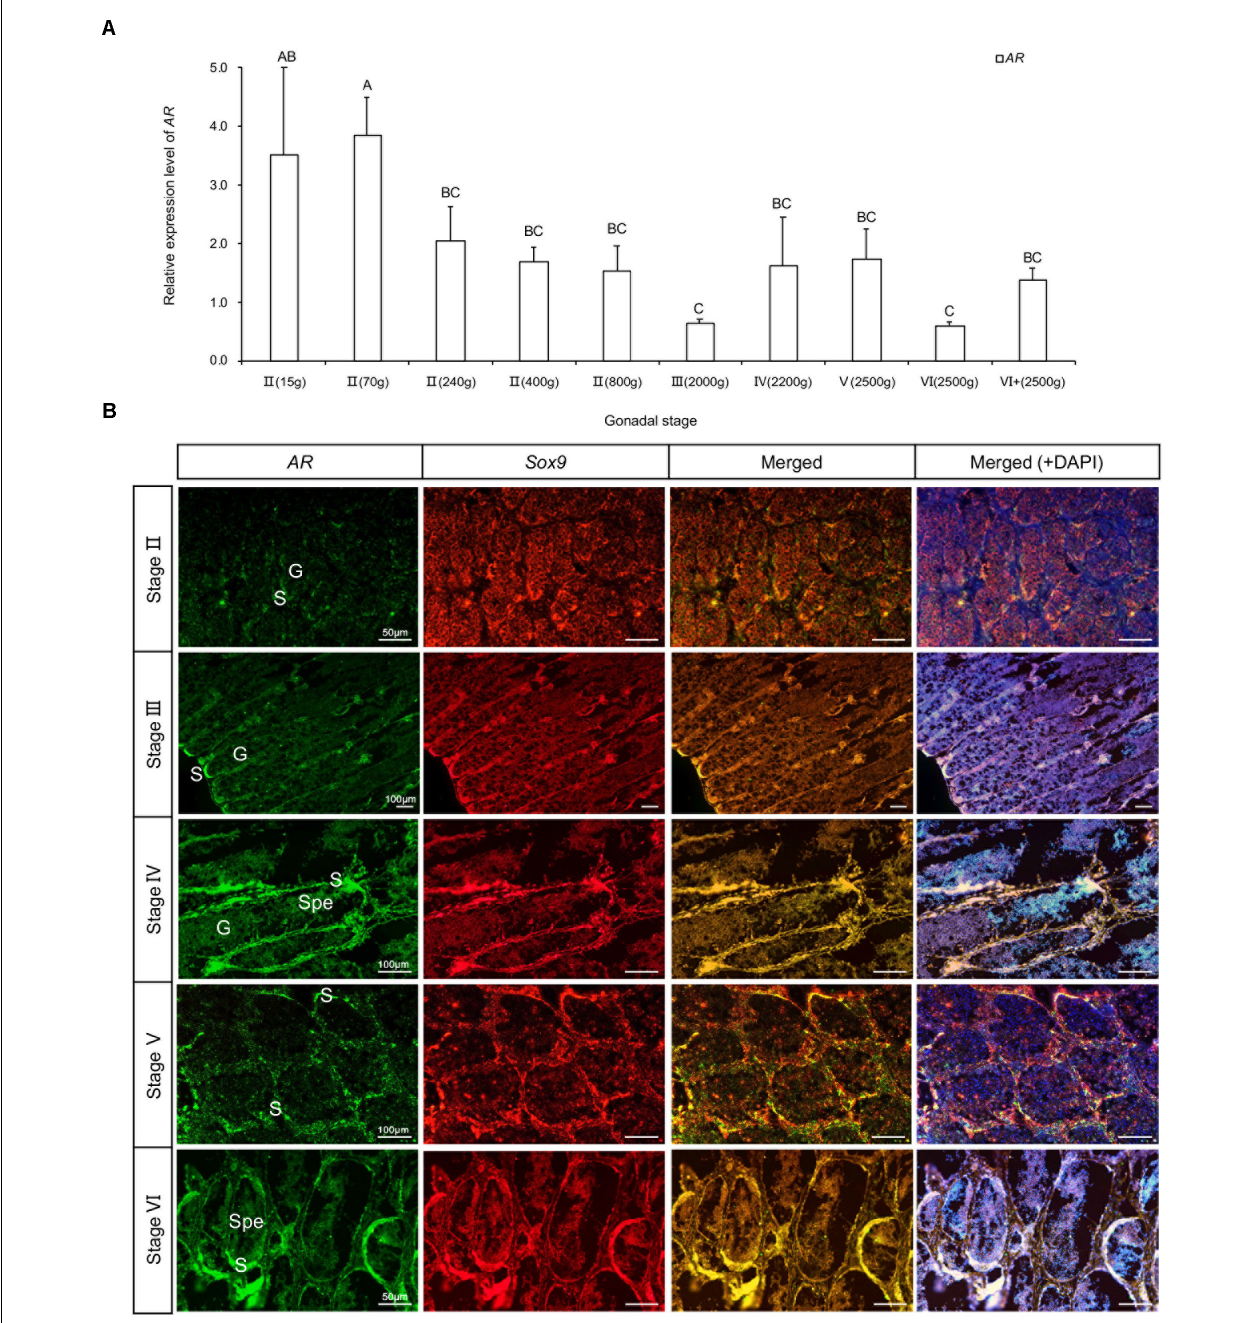
FIGURE 7 | Expression and location of AR mRNA in testis at different development stages. (A) Relative expression level of AR . (B) Location of AR mRNA. G, germ cell; S, Sertoli cell; Spe, spermatozoa or matured spermatids. P < 0.05, n = 6.